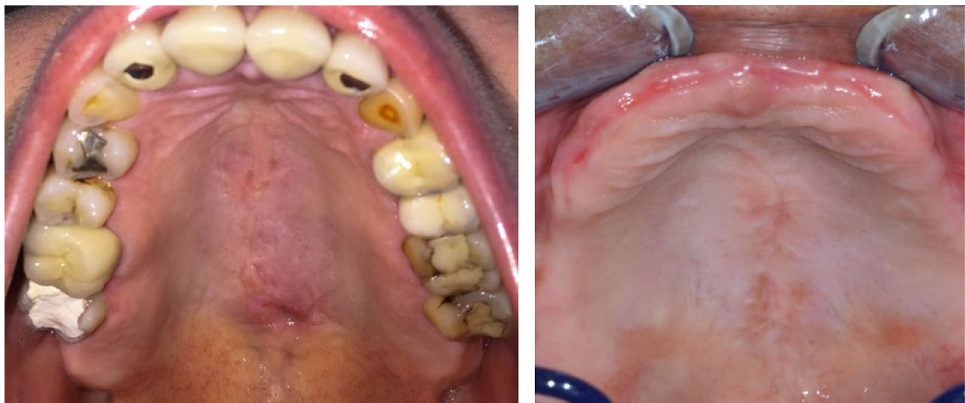
Fig. 6. One-month postoperative control. (a) Patient T. (b) Patient